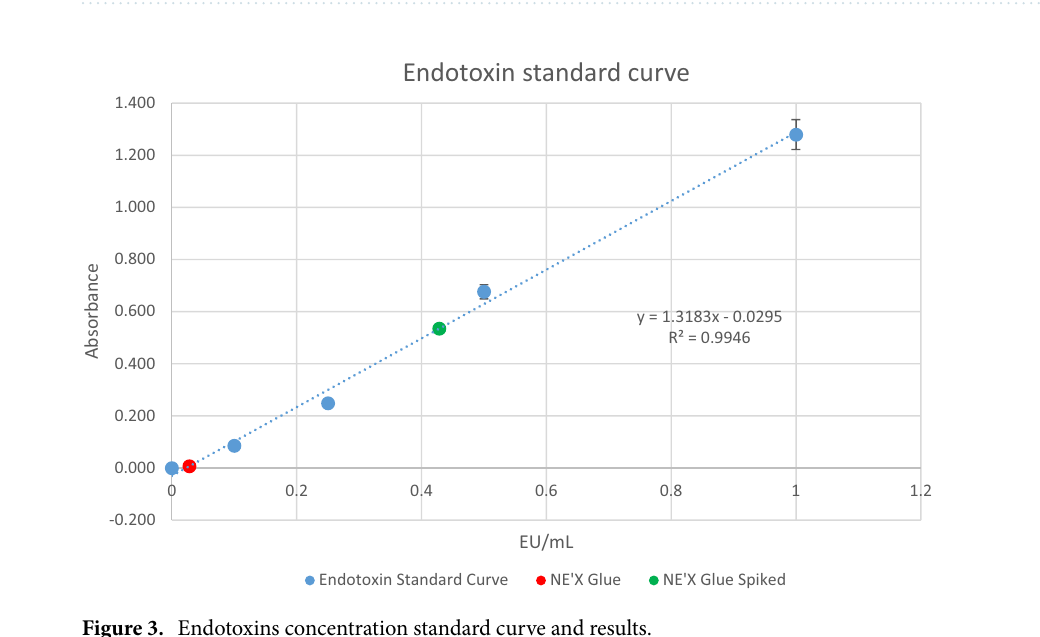
Table 11. Mutagenicity data, 24 h exposure, without metabolic activation. NC negative control, PC positive control.